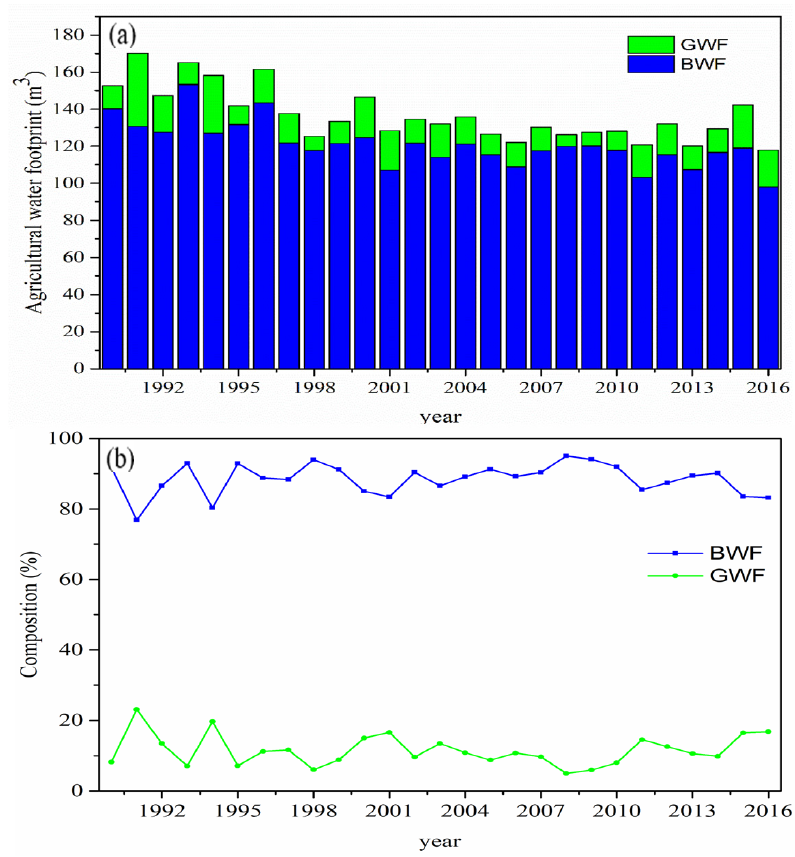
Figure 7. Agriculture water footprints from 1990 to 2016: “( a )” WF blue and WF green annual component values and “( b )” their relative percentage composition of the annual total .